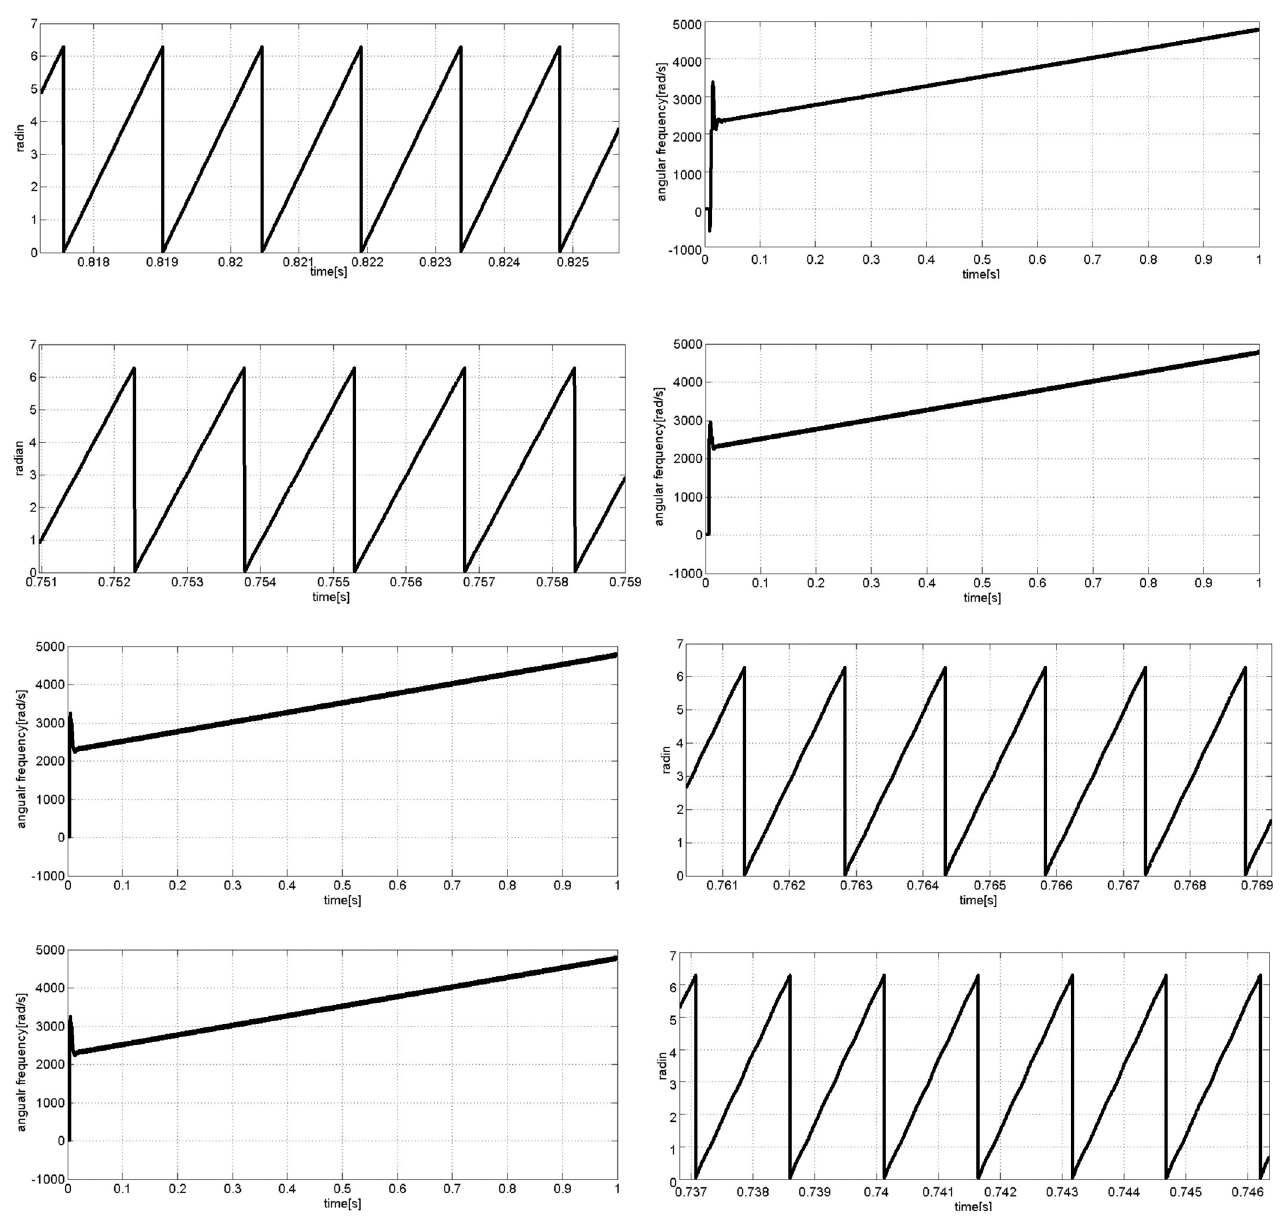
Fig 9. Simulation under frequency